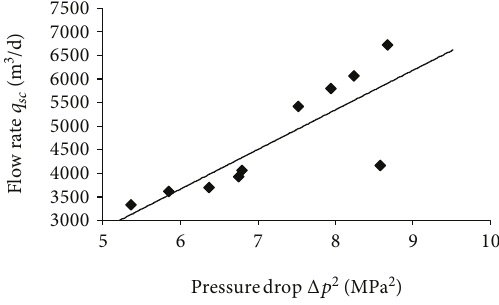
Figure 6: E ff ect of pressure drop on CBM production in two-phase producing